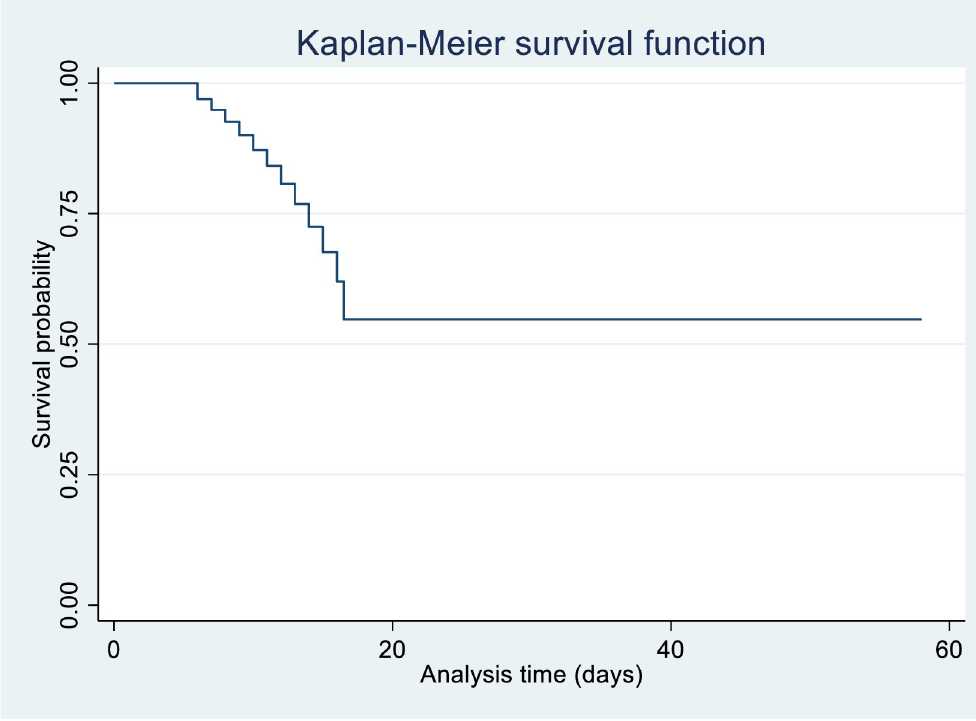
Fig 1. Graph representing overall survival in patients with hematological malignancies and